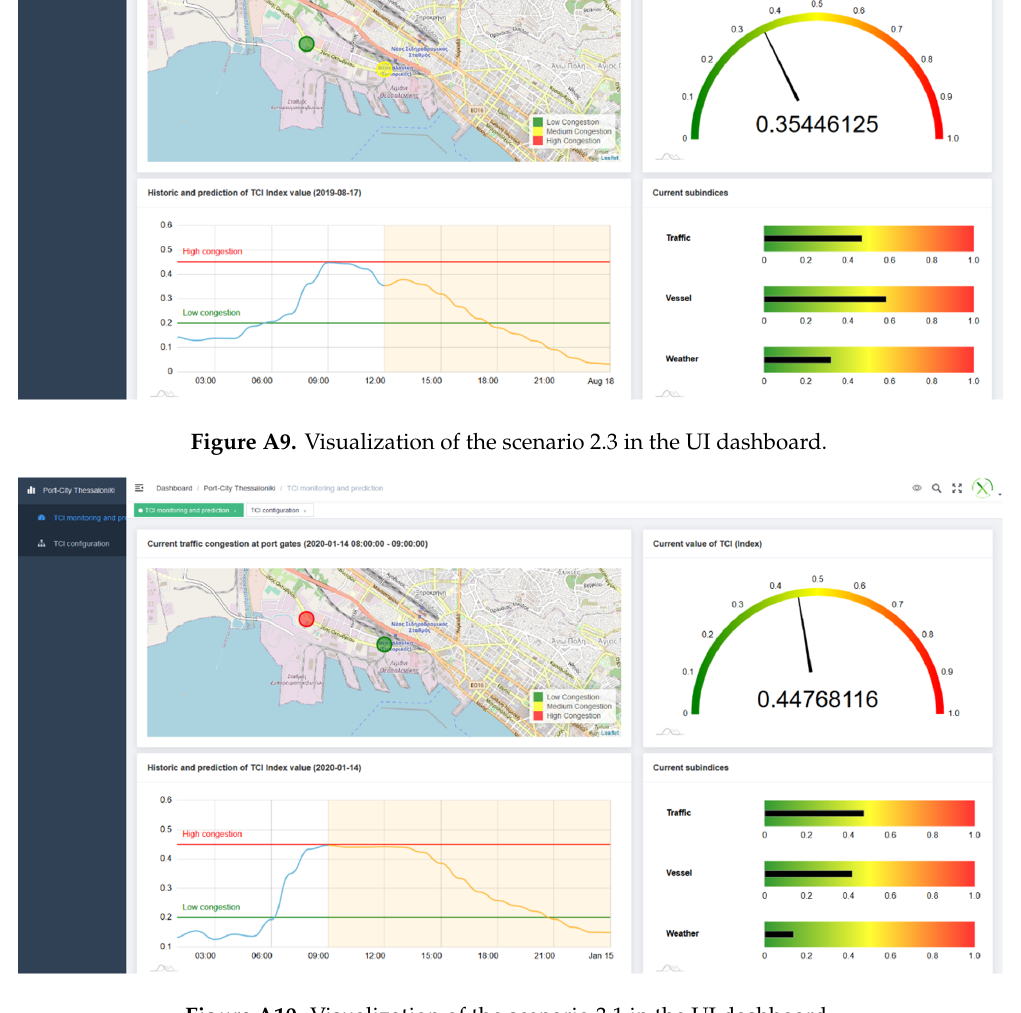
Figure A12. Visualization of the scenario 3.3 in the UI dashboard. References 1.